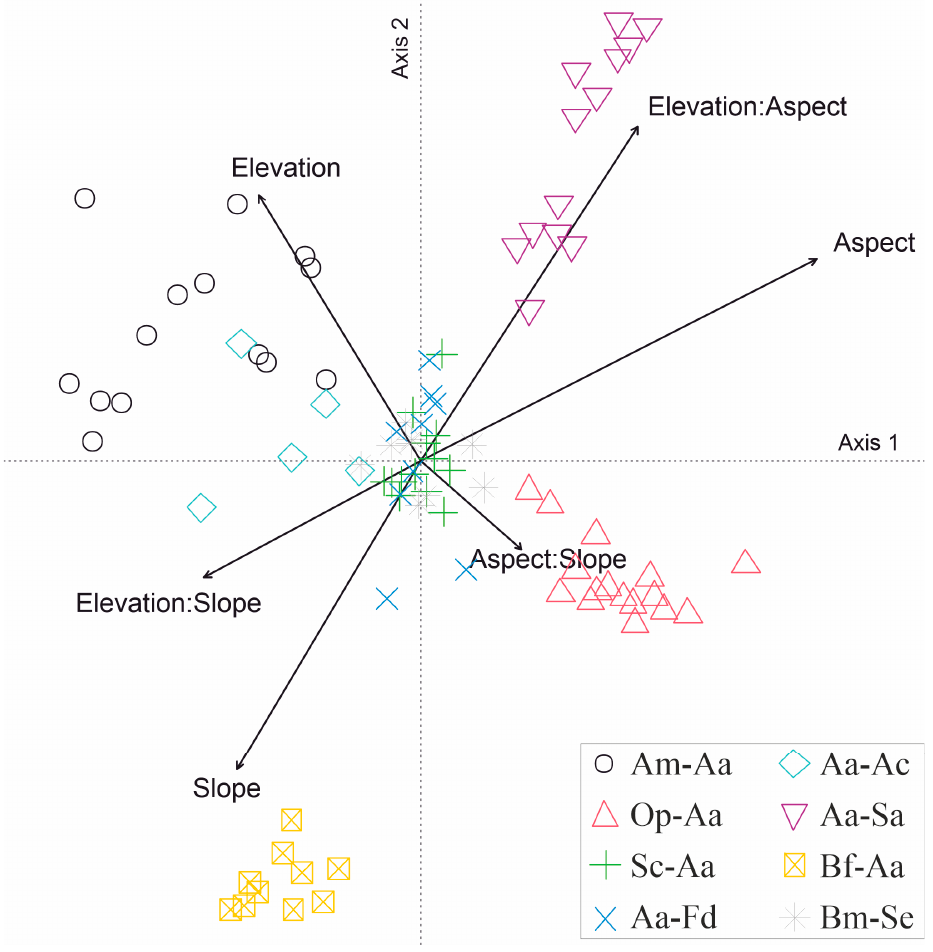
Figure 5. Topographically constrained and spatially conditioned ordination of all relevés (n = 89) in the reduced (bidimensional) species space. Significant predictors in terms of explained variance are represented by vectors. Abbreviations as in Figure 2.